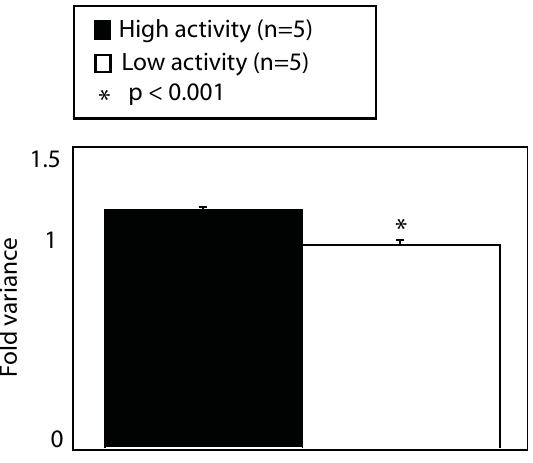
Figure 1. Variance of log-transformed gene expression levels in the hippocampus is associated with individual differences in activity in the open field. Gene expression was log-transformed to reduce normally distributed noise and because of a recognized skewing of gene expression data to low expression values. Variance of log- transformed gene expression levels was significantly increased in mice selected for stable high activity in the open field.